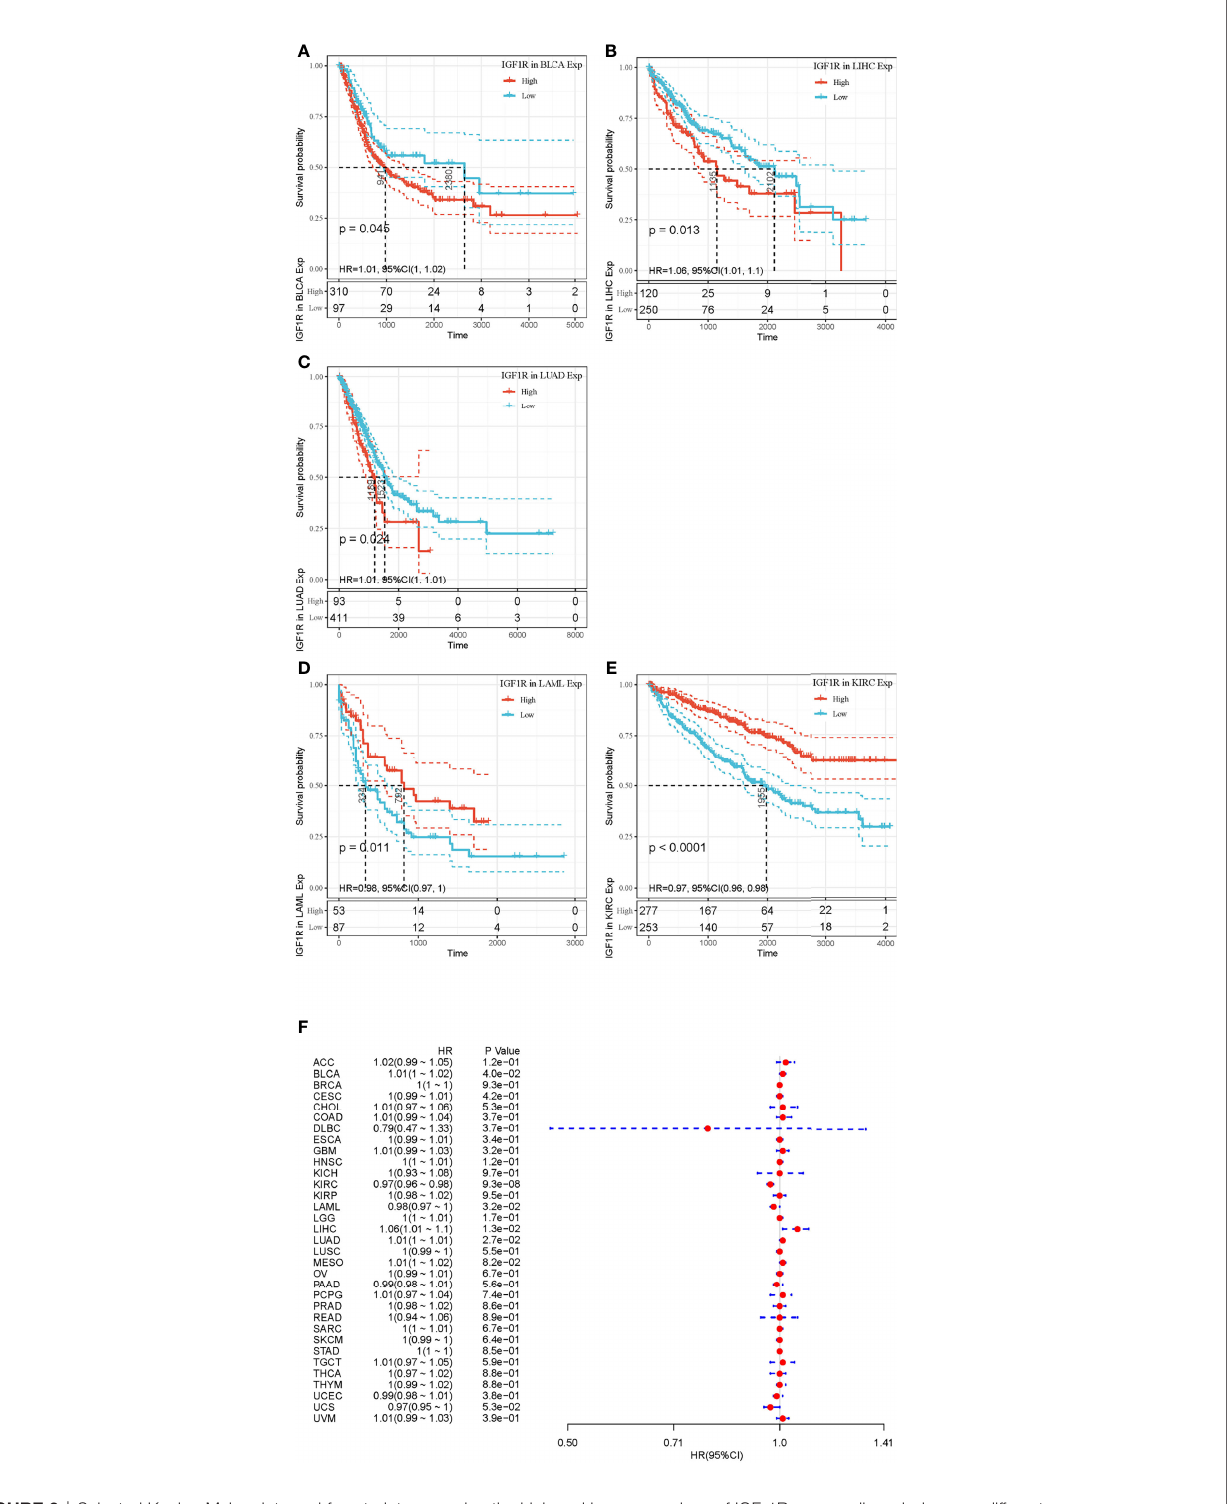
FIGURE 3 | Selected Kaplan-Meier plots and forest plot comparing the high and low expressions of IGF-1R on overall survival across different cancers. (A – C) Kaplan-Meier method showed high expression of IGF-1R correlated with unfavorable prognosis in BLCA, LIHC, and LUAD. (D , E) Kaplan-Meier method showed high expression of IGF-1R correlated with favorable prognosis in LAML and KIRC. (F) Forest plot displaying the impact of high expression of IGF-1R on OS across 33 cancer types using Cox regression